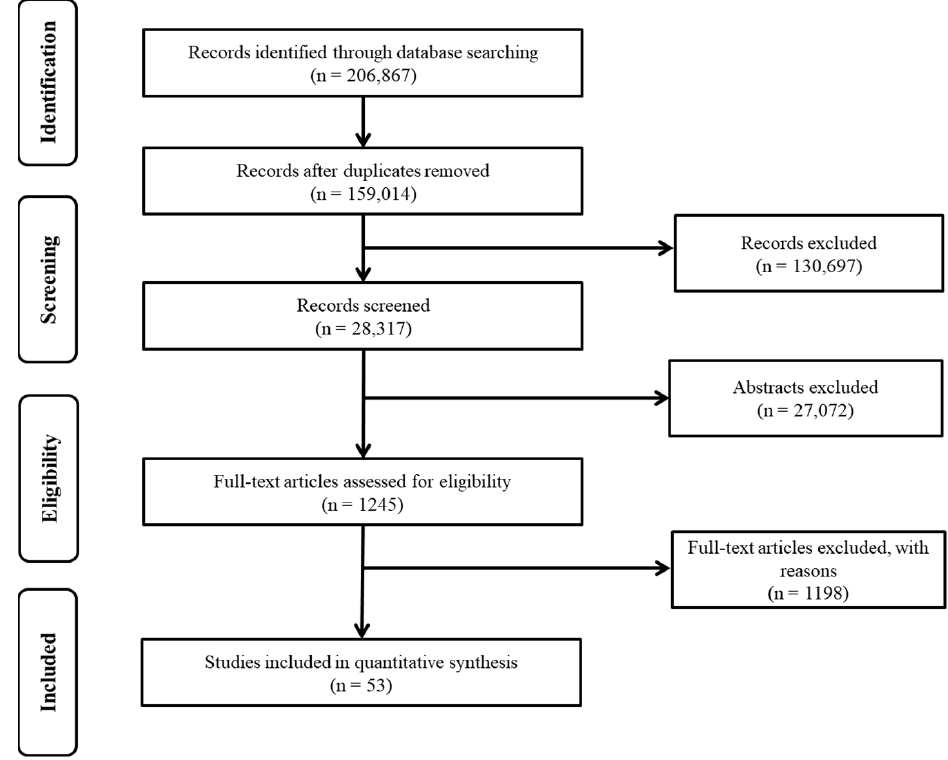
Figure 1. Study selection procedure.